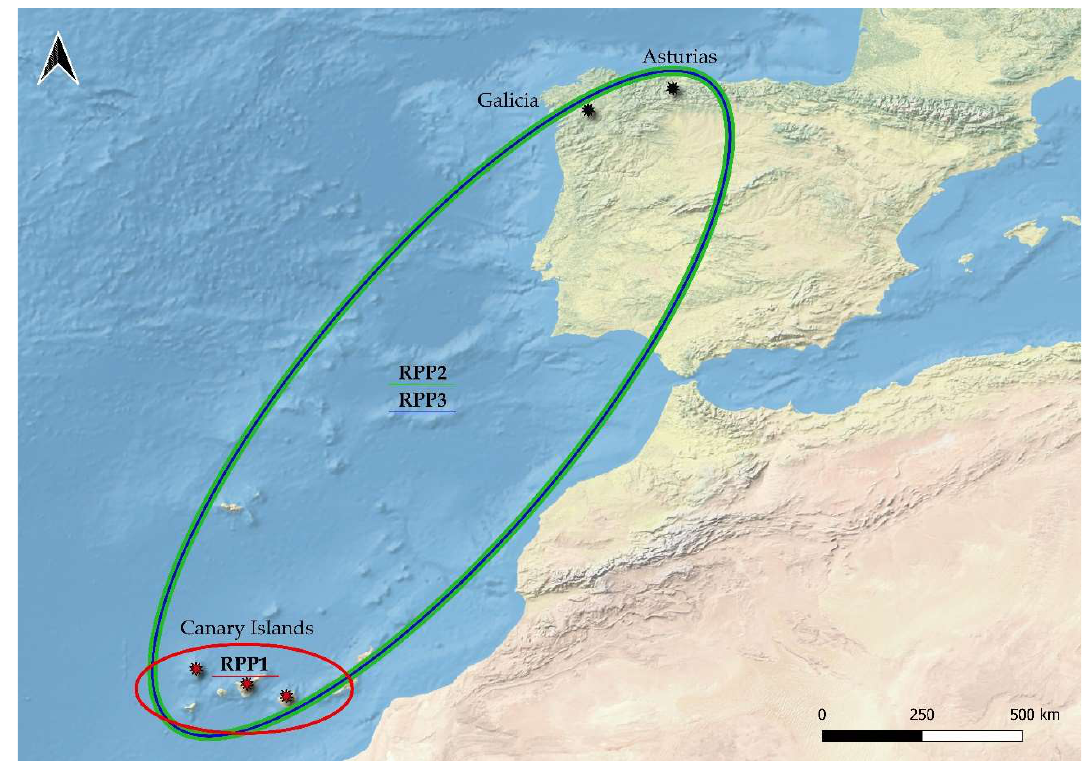
Figure 1. Geographical locations of the 456 samples of pear tree ( Pyrus spp.) included in this study. RPP1: reconstructed panmictic population unique to the Canary Islands; RPP2, RPP3: reconstructed panmictic populations identified in the northwestern Iberian Peninsula and the Canary Islands.